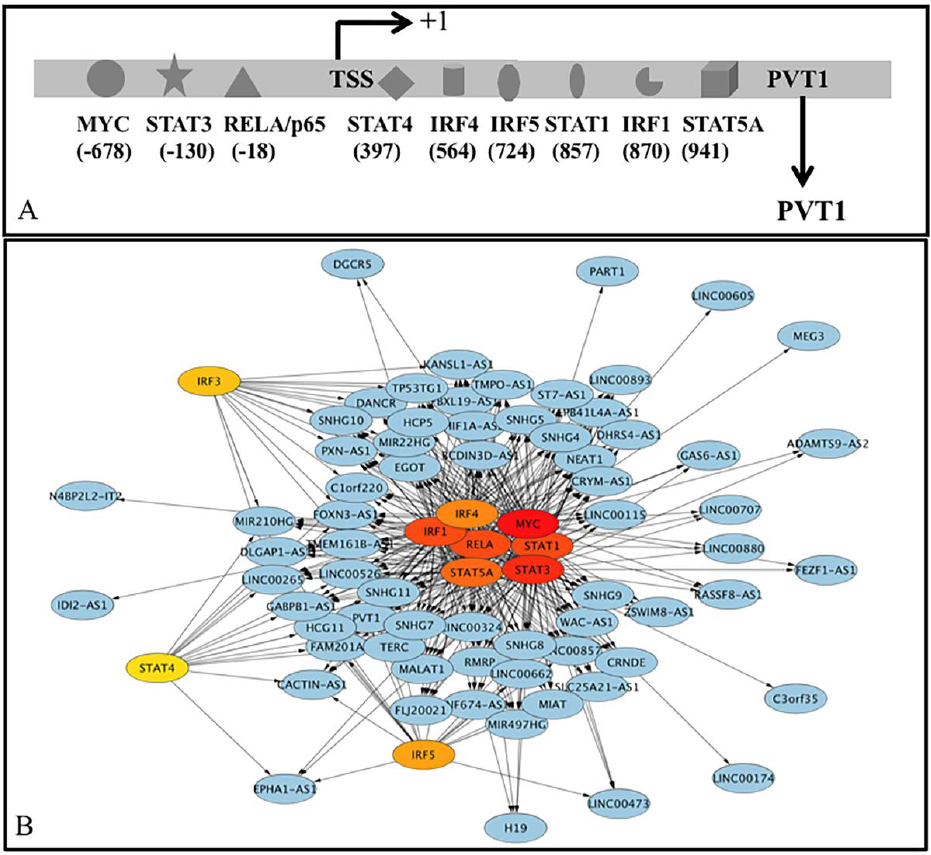
Figure 8. ( A ) (top panel): Binding of TFs to the putative promoter (−5 Kb to +1 Kb) of PVT1.